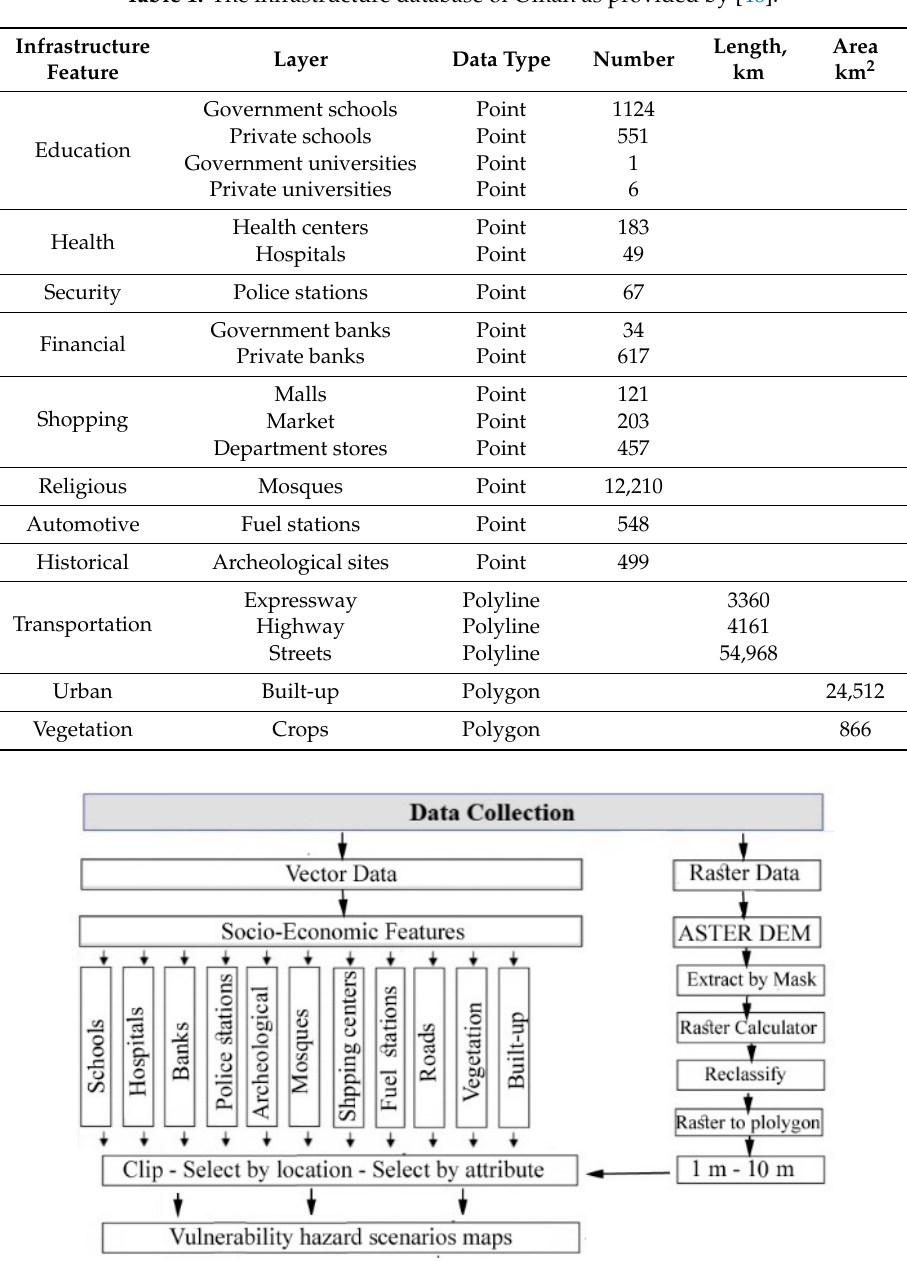
Table 1. The infrastructure database of Oman as provided by [46].